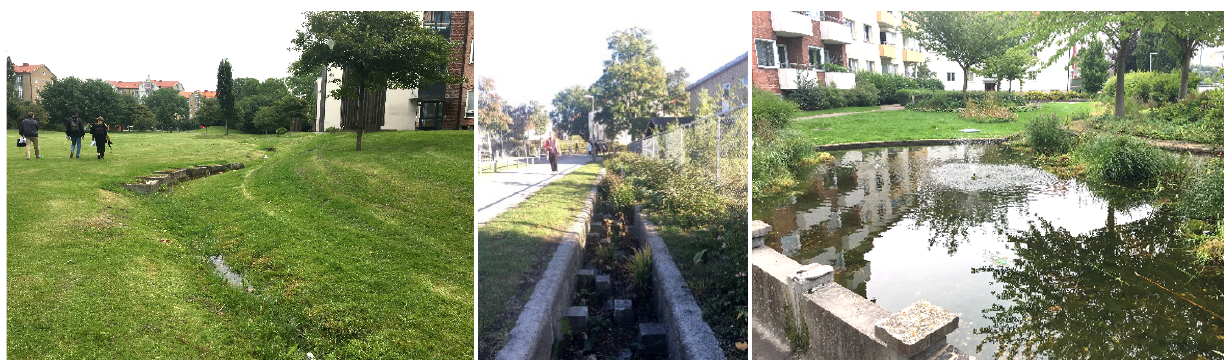
Figure 2. From left to right: Sunken lawn (part of Augustenborg remodelled park); one of the paved canals; one of the wet ponds. Source: Misagh Mottaghi.